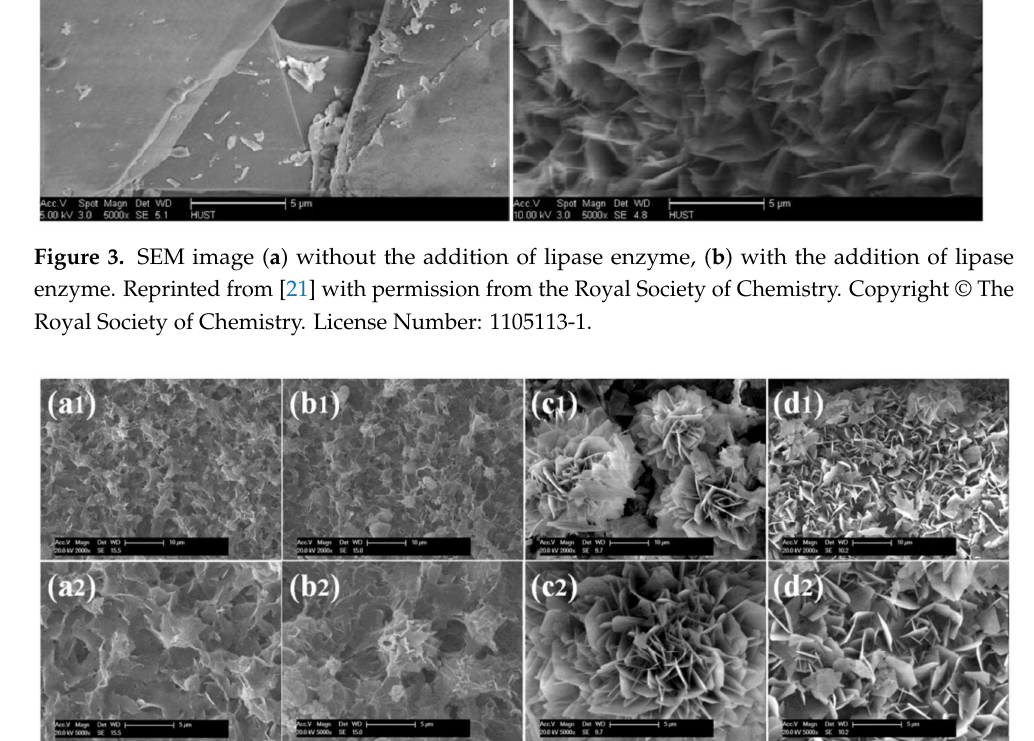
Figure 4. SEM images of different ChT concentrations on the formation of nanoflowers: ( a1 , a2 ) 0.0 mg/mL, ( b1 , b2 ) 0.05 mg/mL, ( c1 , c2 ) 0.1 mg/mL, and ( d1 , d2 ) 0.5 mg/mL. Reprinted from [22] with permission from the Royal Society of Chemistry. Copyright © The Royal Society of Chemistry. License Number: 1105121-1.